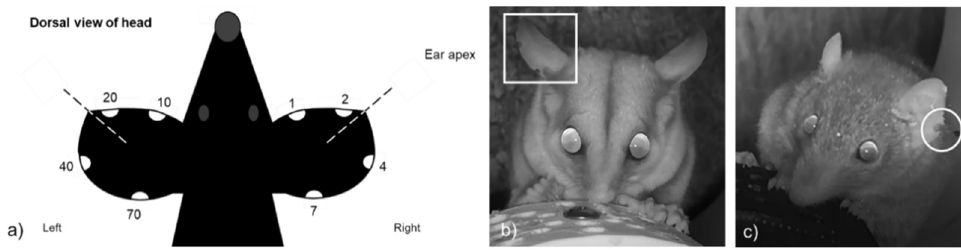
Figure 2. For small mammals captured, a unique code that corresponded with ear notching, was assigned ( a ). The appearance of these unique ear codes on selfie trap footage is shown in two exam- ples: ( b ) a female sugar glider ( Petaurus breviceps ) is shown with the code ‘03’ applied (ear notch 1 and 2); and ( c ) a female antechinus ( Antechinus stuartii ) is shown with code ‘40’ applied (ear notch